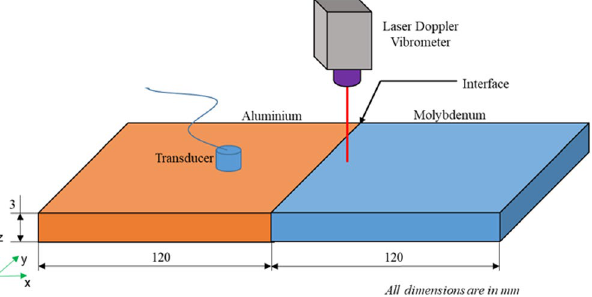
Figure 3. Schematic of the experimental setup. Thickness of proposed lens is 3 mm, the thickness at which S2 of aluminium intersects with S2b of